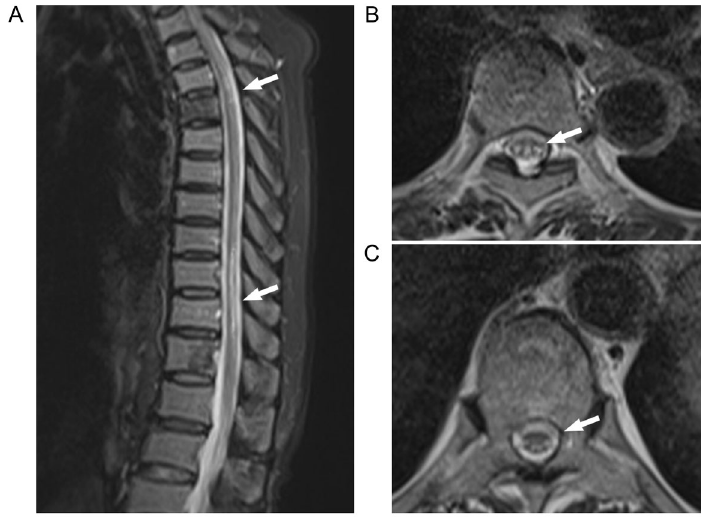
Figure 4. T 2 -weighted magnetic resonance images of thoracic vertebra in Case 2. A , Sagittal view shows high-signal intensity lesions in the thoracic spinal cord (arrows). B and C , Axial views show the spinal cord ‘‘ small print ’’ sign at different positions in the thoracic segment ( B , T5 level; C , T10-T12 level;